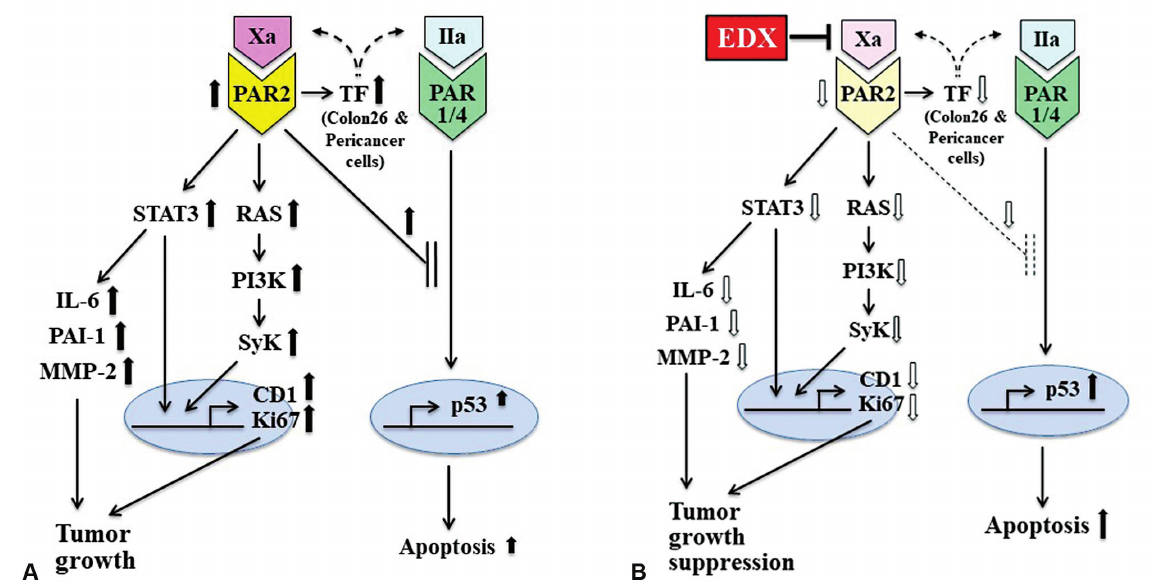
Fig. 8 The proposed basic mechanism of the effect of edoxaban (EDX) on tumor growth and apoptosis mediated by factor Xa-PAR2. ( A ) In the absence of EDX, tissue factor (TF) expressed in inoculated Colon26 cells activates blood coagulation and in fl ammation in host mice, and generated factor Xa activates PAR2, whereas generated thrombin possibly activates PAR1/PAR4 on Colon26 cells and various stroma cells in the tumor microenvironment. PAR2 activation stimulates TF expression, STAT3-mediated IL-6, PAI-1, and MMP-2 production in peri-cancer cells, and RAS/PI3K/SyK/Ki67/cyclin D1 signaling pathways in tumor cells ( black upward arrows ). These affect tumor growth. In addition, thrombin- mediated PAR1 and PAR4 pathways induce p53 expression, leading to apoptosis, which may be regulated by the PAR2-dependent system. ( B ) EDX administration to mice suppressesfactorXa-mediated PAR2activation, reducingPAR2 levels, followedby adecrease in plasmaTF, IL-6, PAI-1, and MMP-2 levels and RAS/PI3K/SyK/Ki67/cyclin D1 signaling pathways ( white downward arrows ), leading to tumor growth suppression. Furthermore, suppression of PAR2 pathway activation by EDX may reduce the regulatory system against the PAR1/PAR4 pathway and may increase the p53-dependent apoptosis ( black upward arrows ► Fig. 8 summarizes the presumed basic mechanisms of